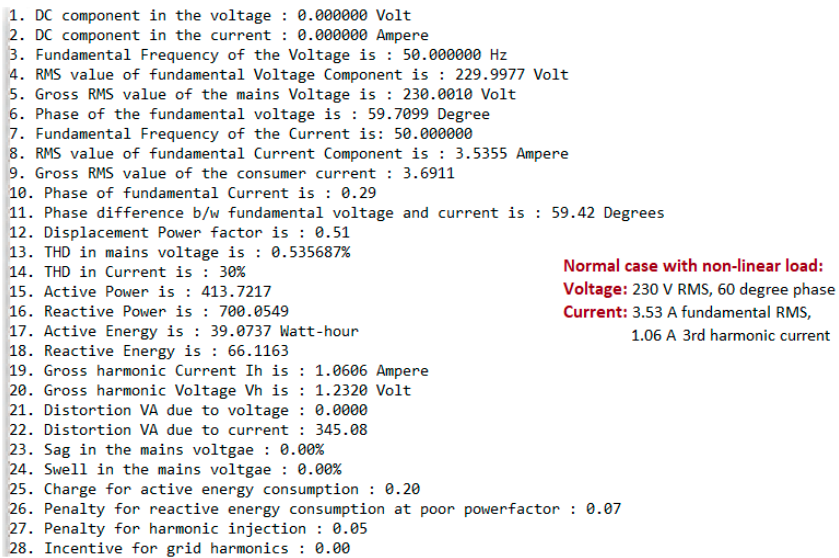
Figure 10. Display of 28 PQ parameters.